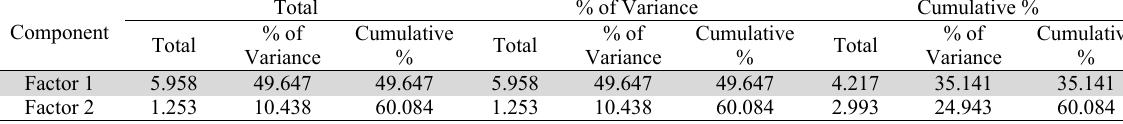
The summary of PCA for factors influencing on firm performance Component